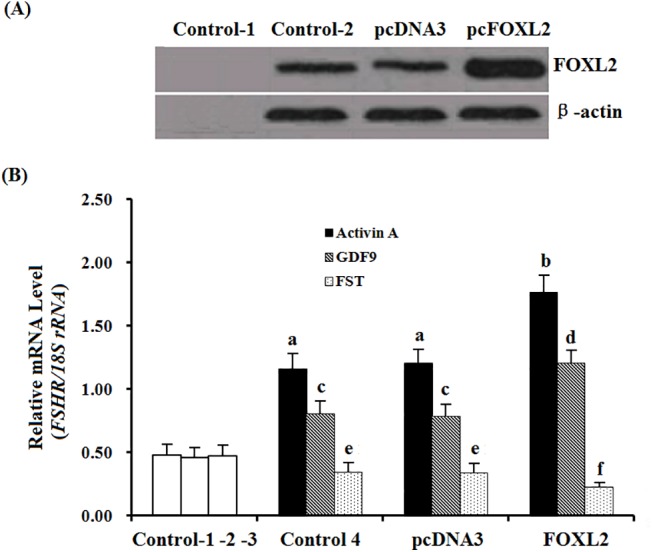
Variation of the expression of FSHR mRNA in the granulosa cells transfected by reconstructed pcDNA3.0-FOXL2 plasmids and cultured with activin A, GDF9 and follistatin.(A), the total cellular extracts were subjected to Western blot analysis. Chicken β-actin (42 kDa) was used as the loading control. Control 1, negative control, without cellular extracts; Control 2, the granulosa cells cultured with the basal medium, no transfection with pcDNA3.0 blank vector or the reconstructed plasmid pcDNA3.0-FOXL2 vector, indicating the endogenous FOXL2 was expressed. pcDNA3, the cells were transfected only by pcDNA3.0 blank vector, also indicating the endogenous FOXL2. pcFOXL2, the cells were transfected by the reconstructed plasmid pcDNA3.0-FOXL2 vector, indicating a transient expression of a recombinant FOXL2 protein. (B), Variation of the expression of FSHR mRNA in the cells responding to the expression of FOXL2, cultured in presence or absence of activin A, GDF9 or FST to the basal medium as indicated. Control 1, the granulosa cells cultured with the basal medium, no transfection with pcDNA3.0 blank vector or the reconstructed plasmid pcDNA3.0-FOXL2 vector, indicating the endogenous FSHR mRNA was expressed. Control 2, the cells were transfected only by pcDNA3.0 blank vector, also indicating the endogenous FSHR mRNA expression. Control 3, expression of FSHR mRNA in the cells transfected by the pcDNA3.0-FOXL2 plasmid. Control 1–3, absent of any of the activin A, GDF9 and follistatin, Control 4, the cells cultured with the same basal medium to control 1–3, but present of the activin A(10 ng/ml), GDF9 (100 ng/ml) and follistatin (100 ng/ml) as indicated. pcDNA3.0, the cells were transfected by pcDNA3.0 blank vector and cultured same to the control 4; FOXL2, the cells were transfected by the reconstructed plasmid pcDNA3.0-FOXL2 vector. Each treatment was performed in triplicate at 38.5°C in 5% CO2 for 24 h. The values on the bar graphs are the mean ± SEM of 10 hens (n = 10) form a representative experiment. For each treatment, bars with different letter superscripts above them are significantly different in expression levels of FSHR mRNA in the cultured granulosa cells (P < 0.05).